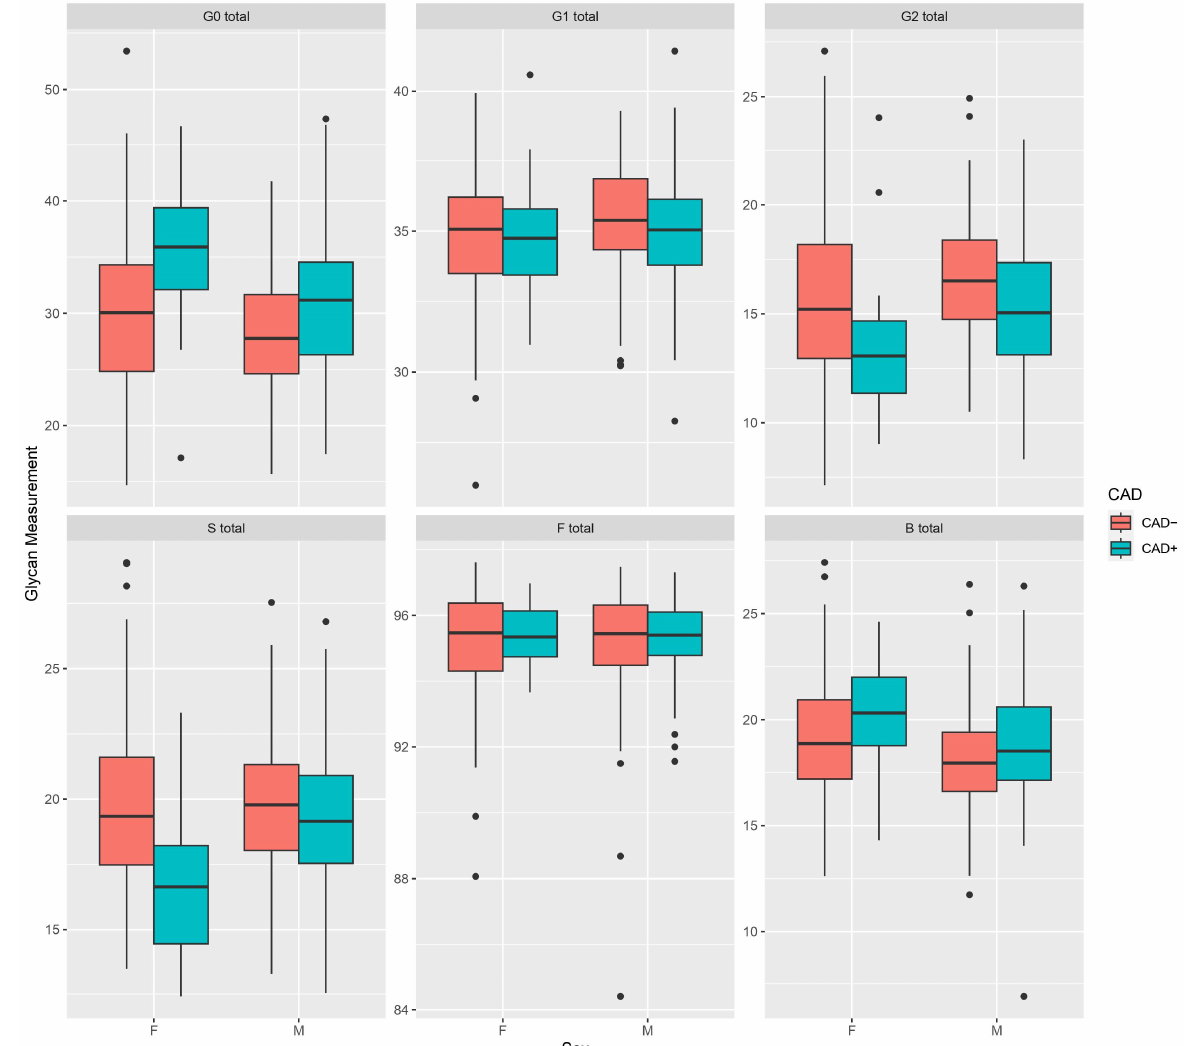
Figure 1. Sex-stratified relative abundance of main IgG glycome derived traits in CAD+ and CAD − cases at inclusion point. G0—agalactosylation, G1—monogalactosylation, G2—digalactosylation, S—sialylation, F—core fucosylation, B—bisecting GlcNAc, F—females, M—males, glycan measurement—expressed as percentage for each derived trait. Boxes represent the 25th and 75th percentiles. Lines inside the box represent the median.